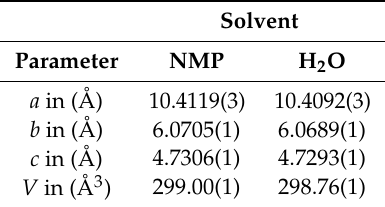
Table 4. Relative charge and discharge capacities and irreversible capacity loss (ICL) observed during the full-cell forming step. Table shows all combinations of sample ageing conditions and subsequently used solvent for slurry preparation. The highest observed charge capacity (147.2